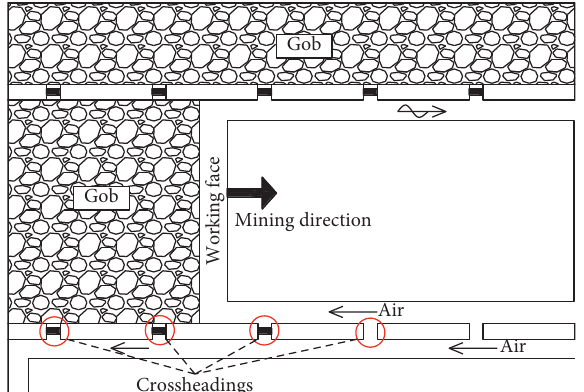
Figure 2: Schematic diagram of a quintessential manway in a Shenfu coalfield: each crossheading is